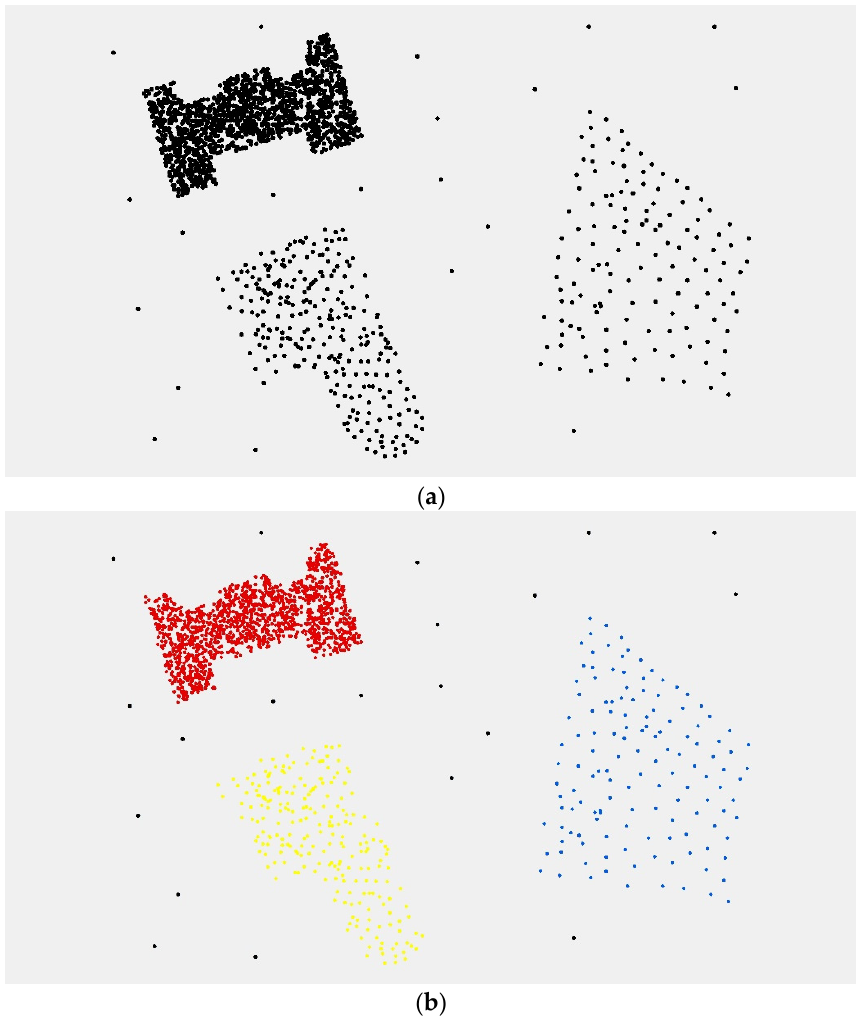
Figure 4. Experimental results. ( a ) Experimental data. ( b ) Clustering result using the CDHC algorithm. ( c ) Clustering result using the CBDT algorithm. ( d ) Clustering result using the DBSCAN algorithm. ( e ) Clustering result using the K-means algorithm. ( f ) Legend.